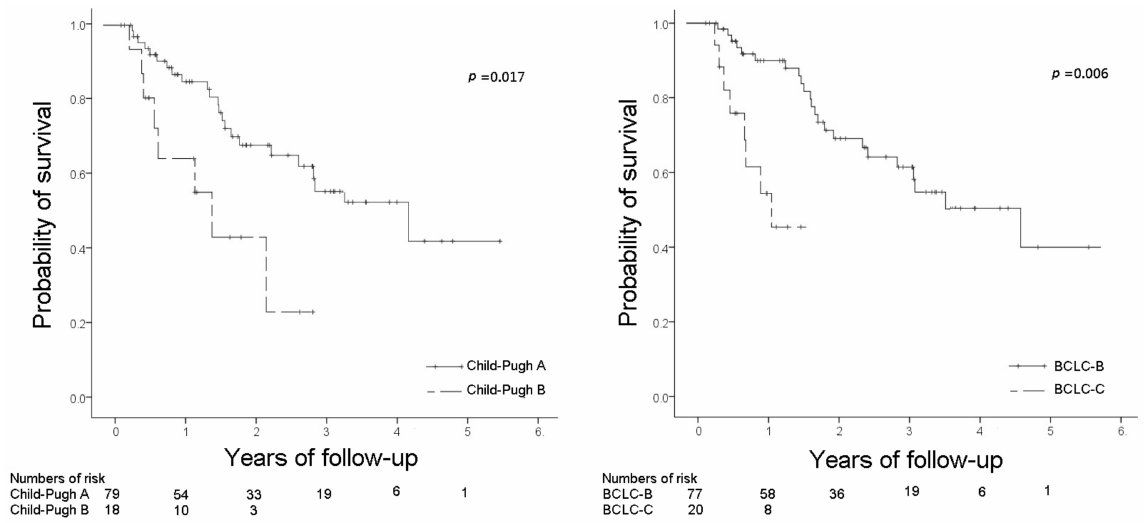
Figure 2. Cumulative probability of survival in the patients with SVR stratified by Child–Pugh stage and BCLC stage (SVR, sustained viral